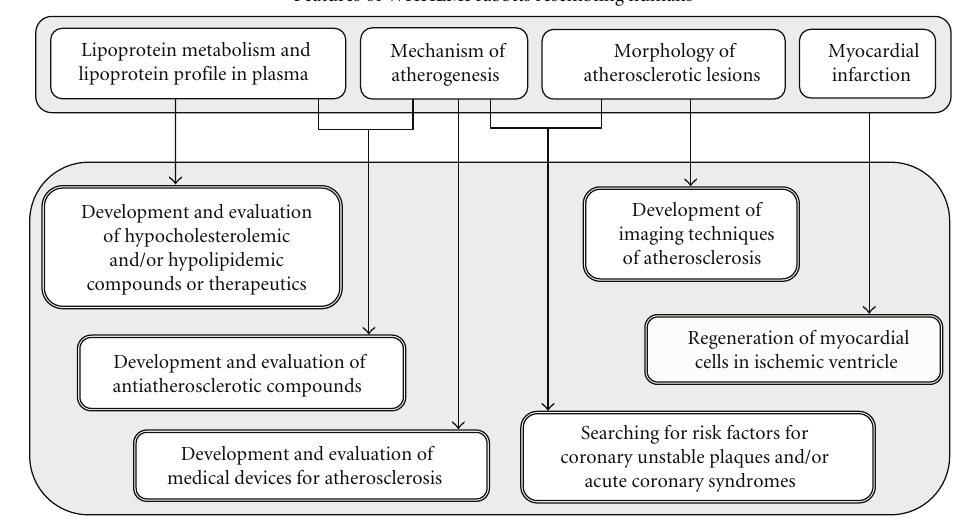
Figure 3: Features of the WHHLMI rabbit resembling humans and applicable translational research